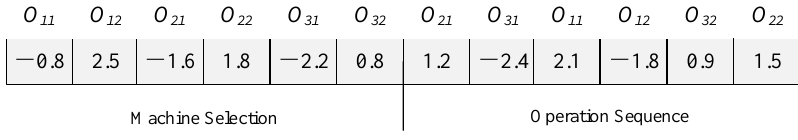
Figure 3. Denotation of Individual Position Vector (IPV).